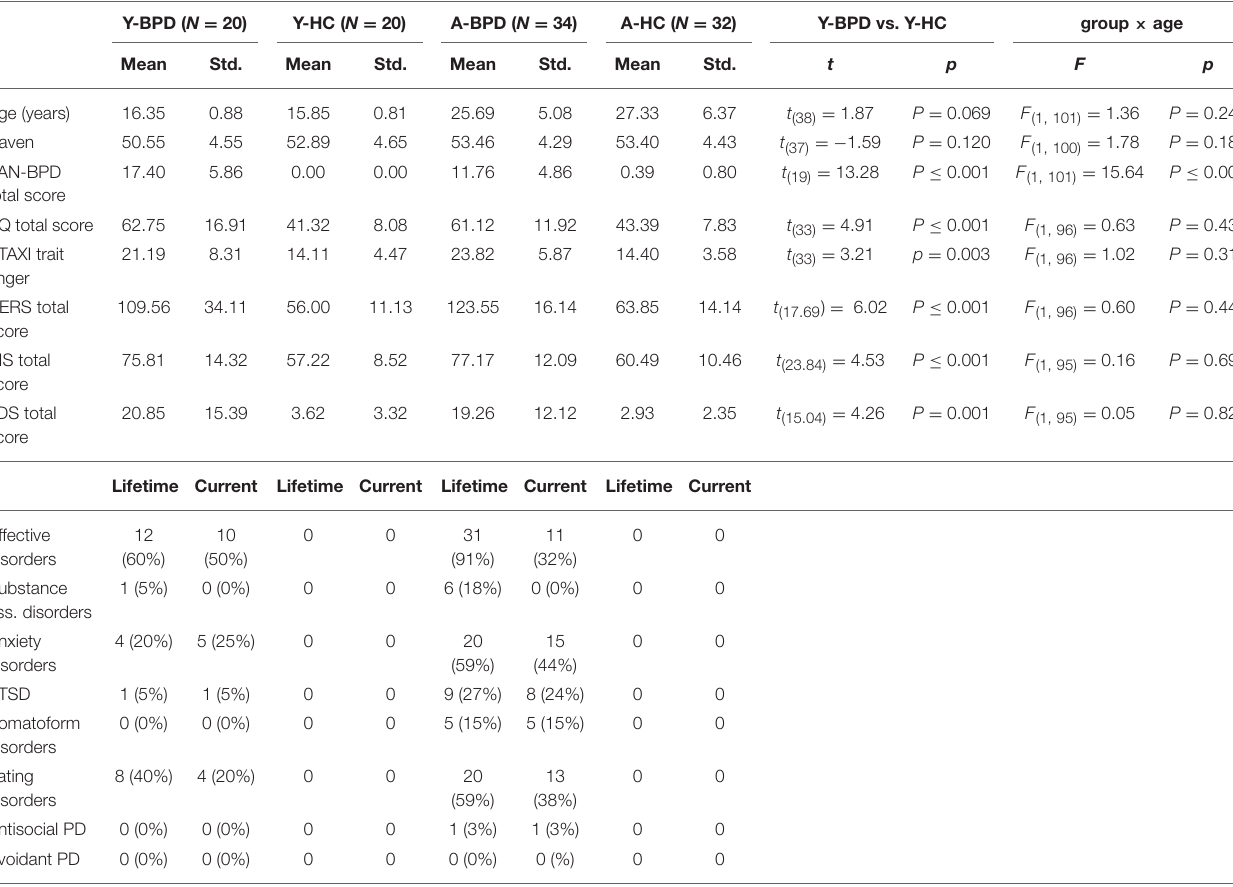
TABLE 1 | Sample description and self-report